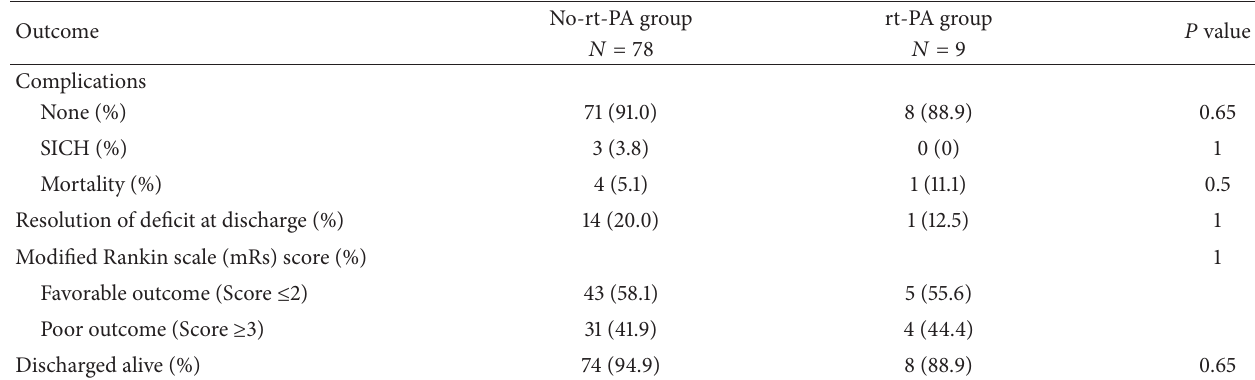
Table 3: Outcomes of patients by Group (rt-PA versus no